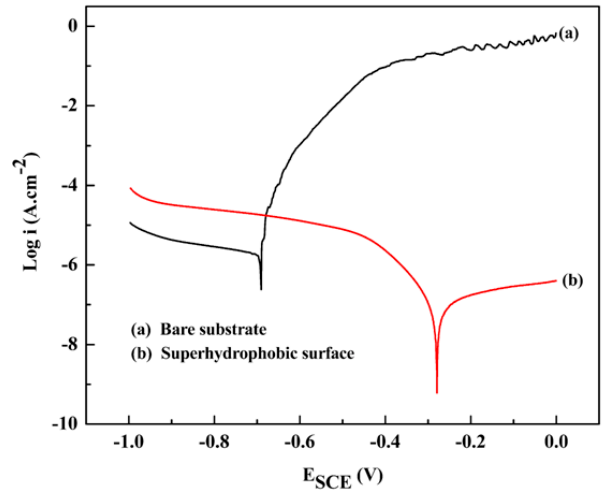
Figure 7. Potentiodynamic polarization curves of bare AA5052 aluminum alloy and superhydrophobic surface in 3.5 wt.% NaCl solution.